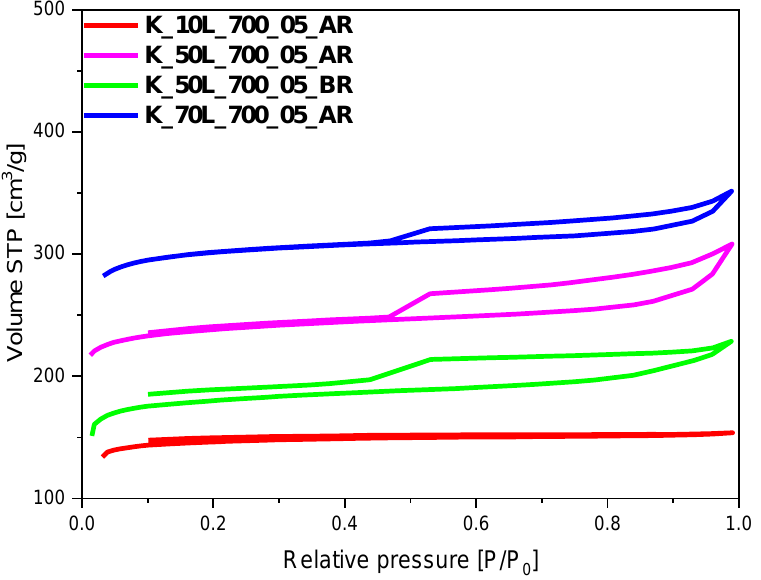
Figure 5. Nitrogen adsorption-desorption isotherms of the sample with KOH added before (K_10L_700_05_BR) or after (K_10L_700_05_AR; K_50L_700_05_AR; K_70L_700_05_AR) micro- wave reactor.